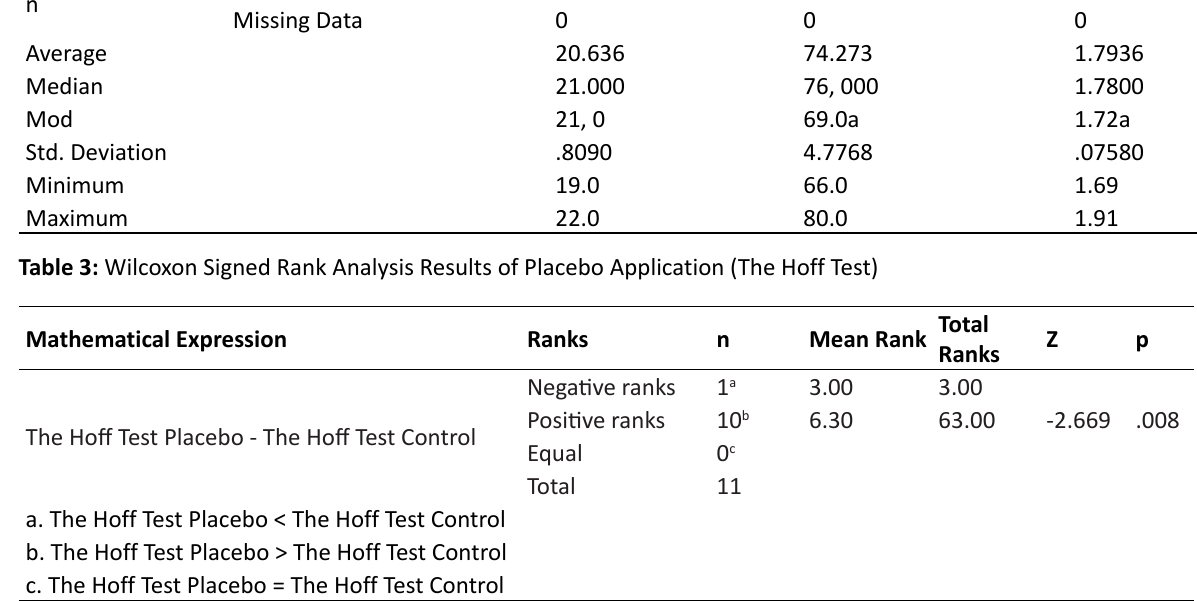
Table 2: Descriptive Statistics Descriptives